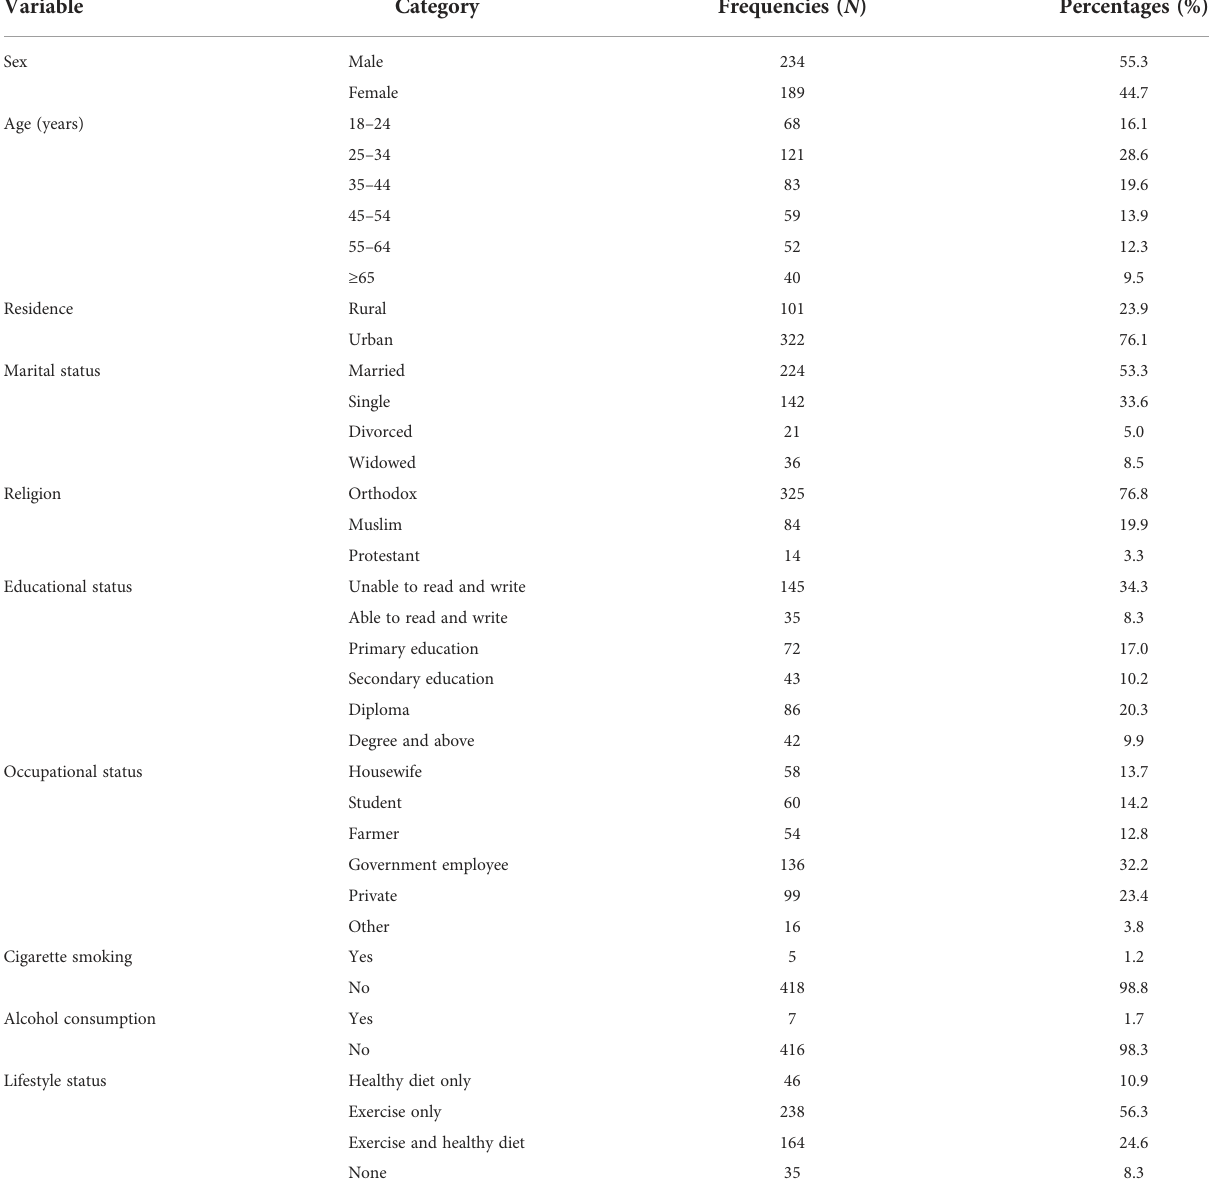
TABLE 1 Sociodemographic characteristics of DM patients attending at Felege Hiwot Comprehensive Specialized Hospital.